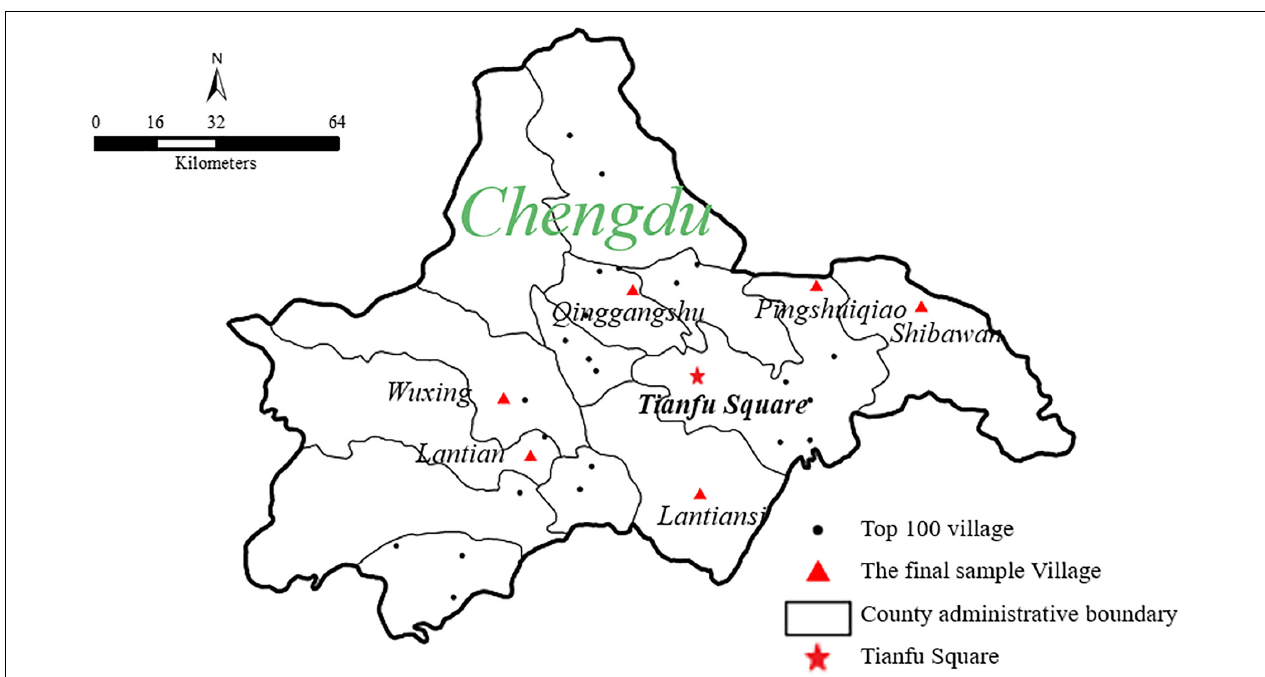
FIGURE 4 | Geographical distribution of the final selected sample villages.